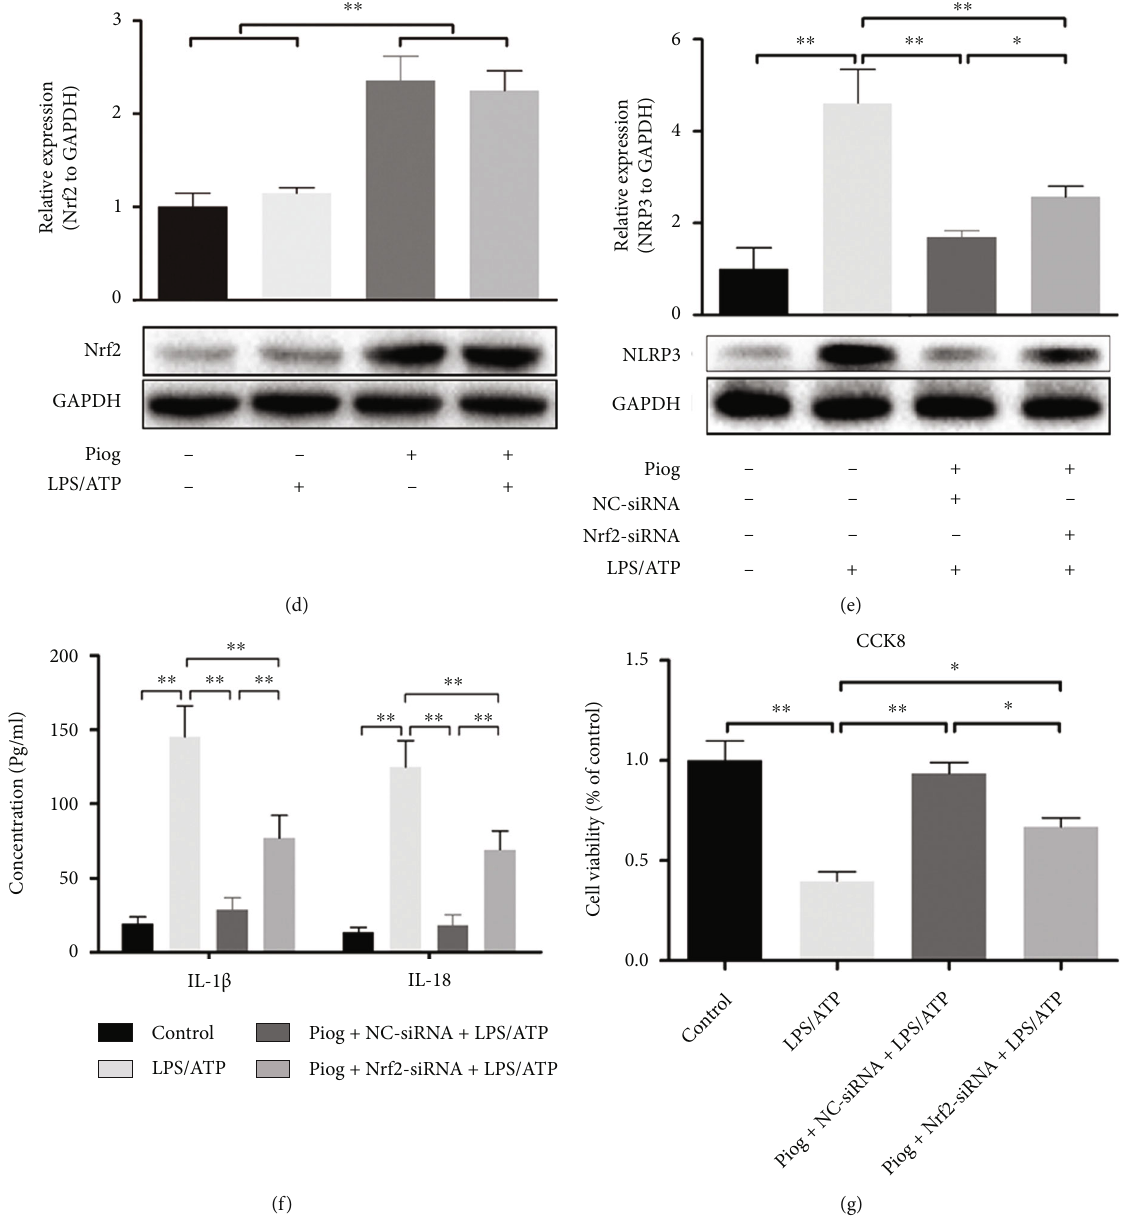
Figure 4: Piog partially attenuates LPS/ATP-induced chondrocyte pyroptosis related to the NLRP3 in fl ammasome through Nrf2 signaling. (a and b) Western blot analysis for NLRP3, caspase-1 P10, and GSDMD-N in the control, LPS/ATP, Piog+ LPS/ATP, and Piog+MSU +LPS/ATP groups. (b) ELISA was performed for IL-1 β and IL-18 concentrations. (c) CCK8 assays were performed to determine the e ff ect of Piog on LPS/ATP-treated chondrocyte viability after MSU activated NLRP3. (d) Western blot analysis for Nrf2 in the control, LPS/ATP, Piog, and Piog+LPS/ATP groups. (e) Western blot analysis was performed to detect NLRP3 level after Nrf2 knockdown by siRNA; (f) ELISA was performed to detect IL-1 β and IL-18 concentrations. (g) CCK8 assays were performed to determine the e ff ect of Piog on LPS/ATP-treated chondrocyte viability after Nrf2 knockdown by siRNA. GAPDH was used as an internal reference for western blotting. Densitometric analysis of the immunoblots is located on the right or below. The data represent three independent experiments and are expressed as mean ± SD. * P < 0 : 05 and ** P < 0 : 01